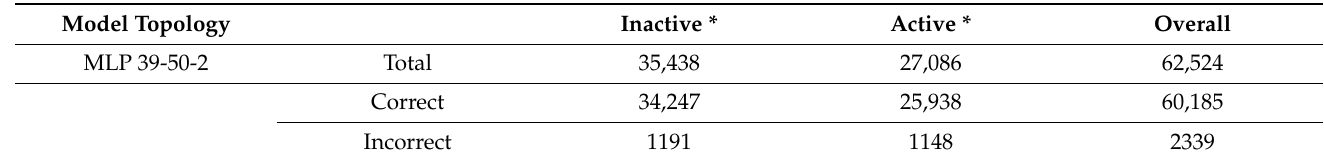
Table 1. The 10 best ANN